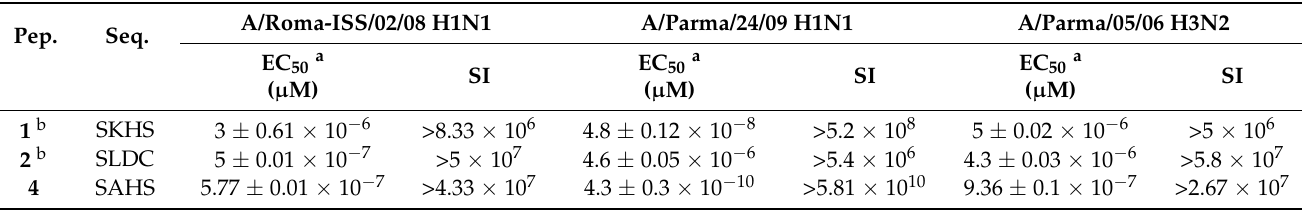
Table 2. In vitro antiviral activity of peptides 1 and 4 against influenza virus infection. a EC 50 : the reciprocal substance dilution at which 50% of cells were protected from the virus-induced killing; ˆSI: the ratio between CC 50 (the reciprocal substance dilution at which 50% of cells were protected from substance toxicity, corresponding to a concentration >25 µ M) and EC 50 ; The mean values of 3 independent experiments with standard errors are shown. b Scala et al. (2017) [14]. Pep.